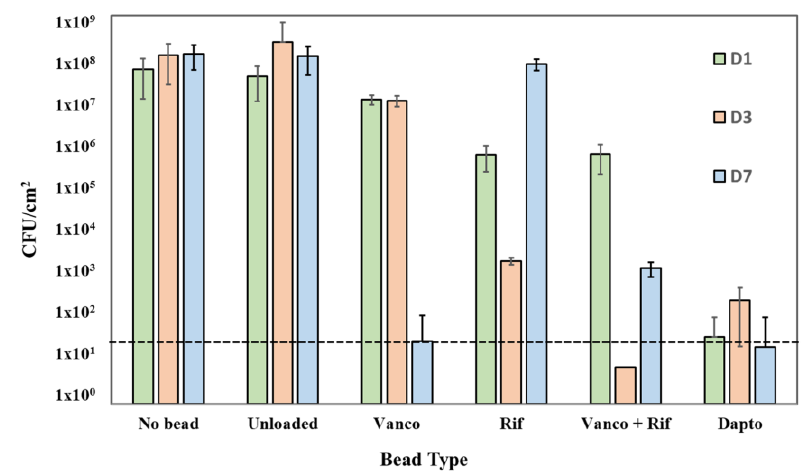
Figure 3. Effect of unloaded beads as well as vancomycin (Vanco), rifampicin (Rif), rifampicin and vancomycin in combination (Vanco + Rif) and daptomycin (Dapto) loaded beads on established S. epidermidis ATCC 35984 biofilms at contact times at days (D) 1,3 and 7. Dashed line is the detection limit. No beads were added as a positive control for biofilm growth. Mean and 95% CI (n = 3), *indicates statistically significant differences from the unloaded beads ( p < 0.05).